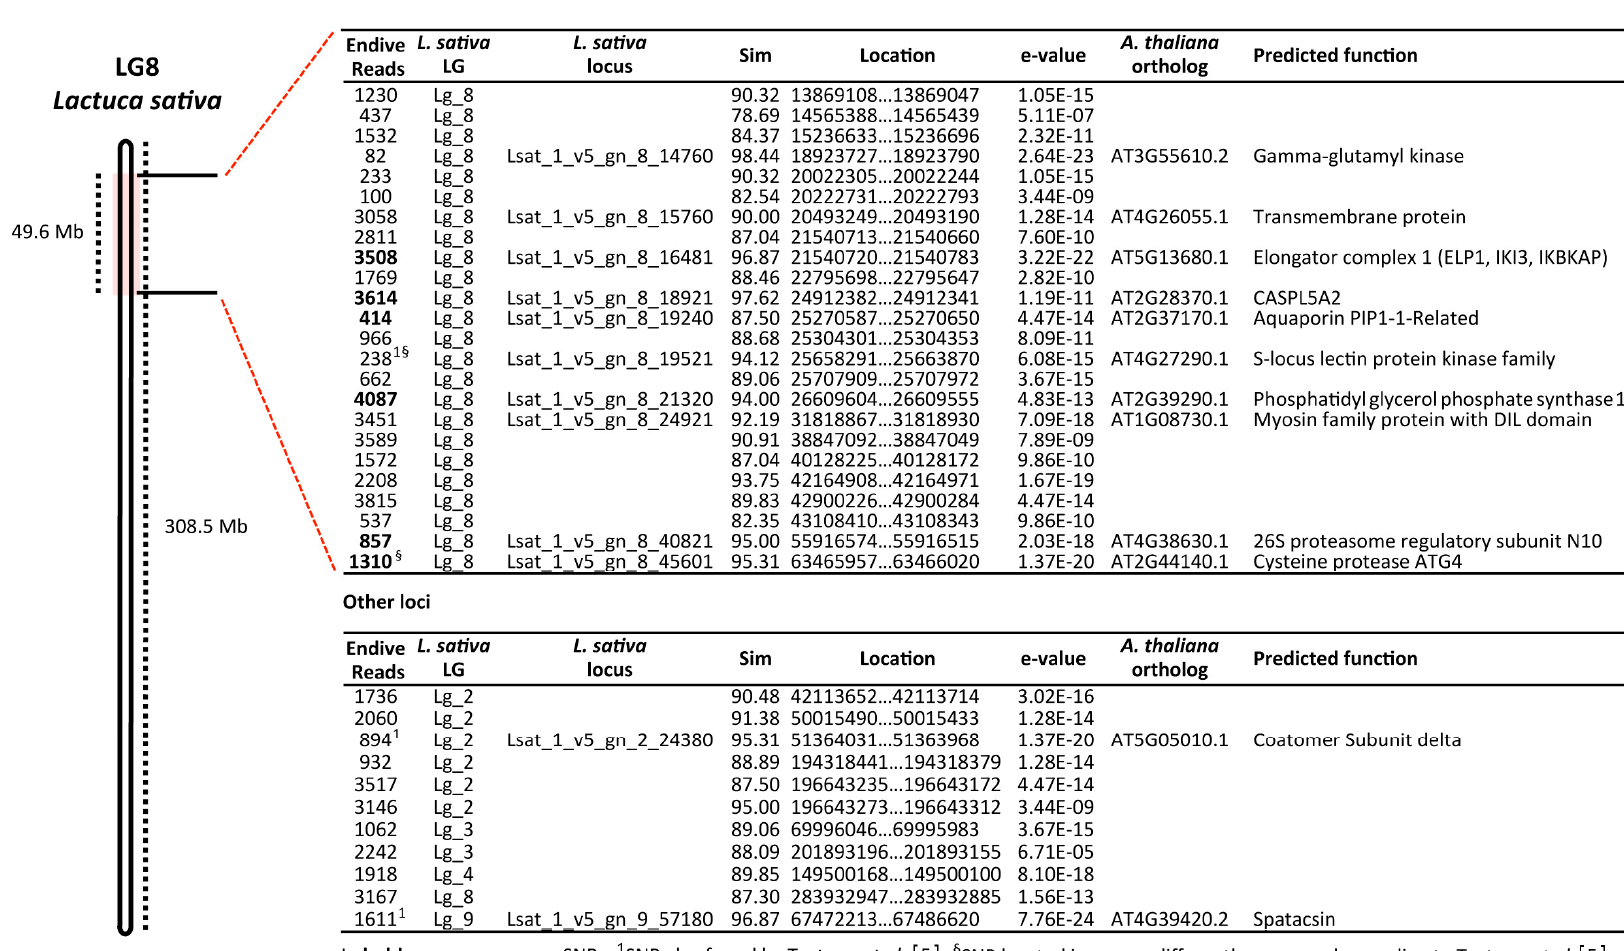
Figure 3. Information on the reads that discriminate escarole from curly endive. The name of the endive single-nucleotide polymorphisms (SNP)-containing reads, Lactuca sativa linkage group (LG), genic locus, similarity location and E-value are reported along with the best Arabidopsis thaliana match and the predicted function. Twenty-four endive reads were mapped within a peripheral segment of chromosome 8 of L. sativa, spanning a DNA region of 49.6 Mb.